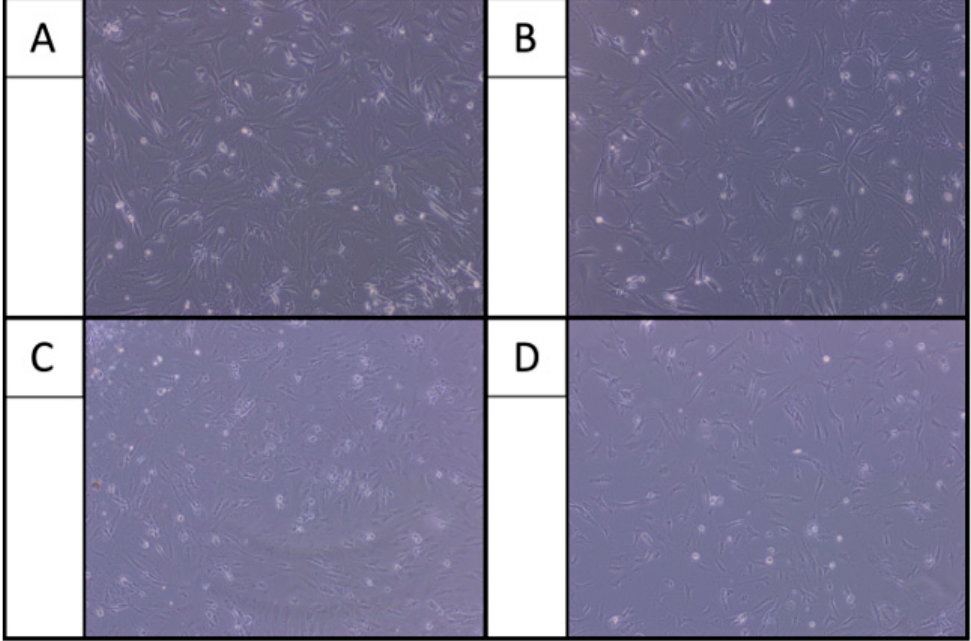
Figure 2. Adding of HA to all LA ( B ) bupivacaine, ( C ) lidocaine and ( D ) ropivacaine resulted in an elongated attachment and branched appearance of the chondrocytes comparable to the control group ( A ).